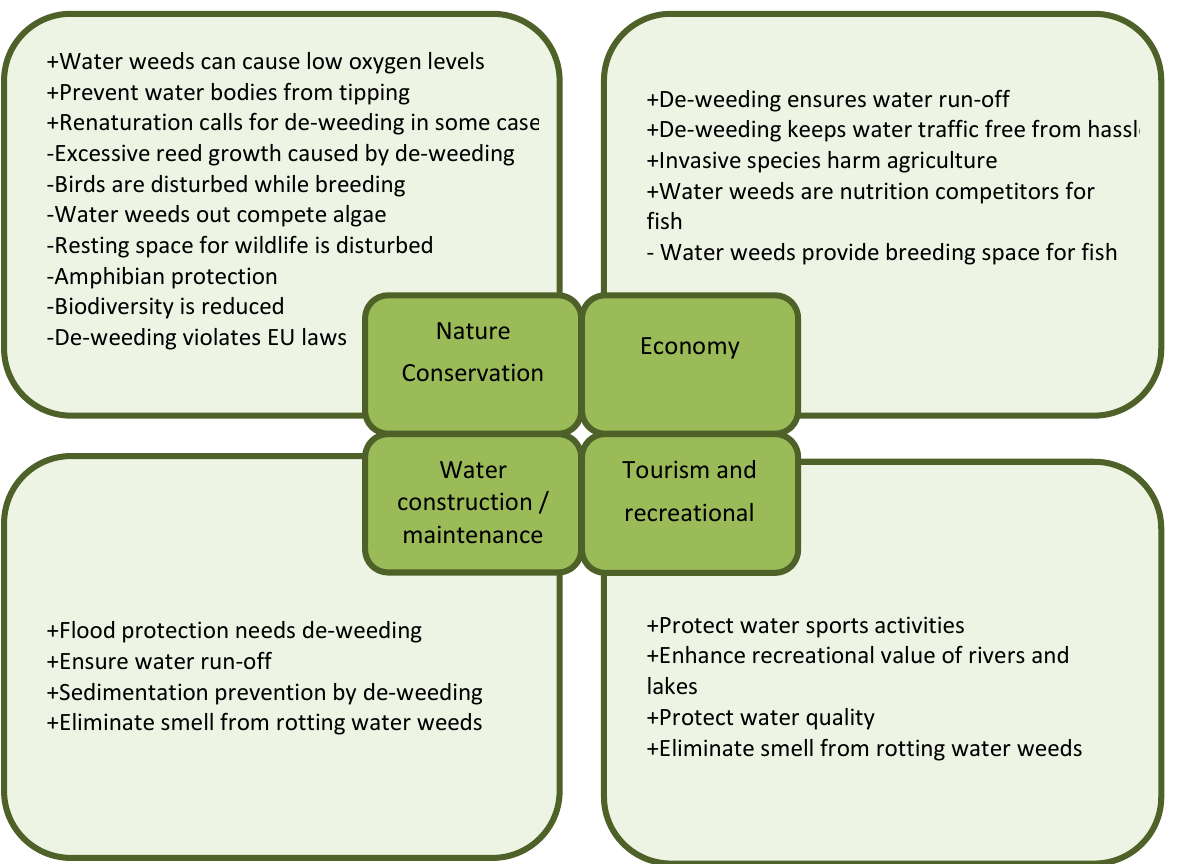
Figure 3 sums up the arguments voiced by the respective stakeholder groups, where a plus sign indicates an argument in favor of de-weeding and a minus sign indicates an argument against.